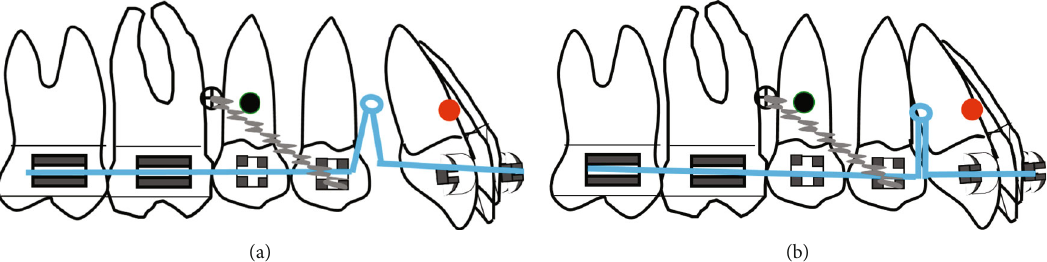
Figure 5: (a) En-masse retraction of the maxillary anterior teeth with loop mechanics while the posterior segment is anchored to the microimplant with a steel ligature to the fi rst premolar. (b) End of en-masse retraction.